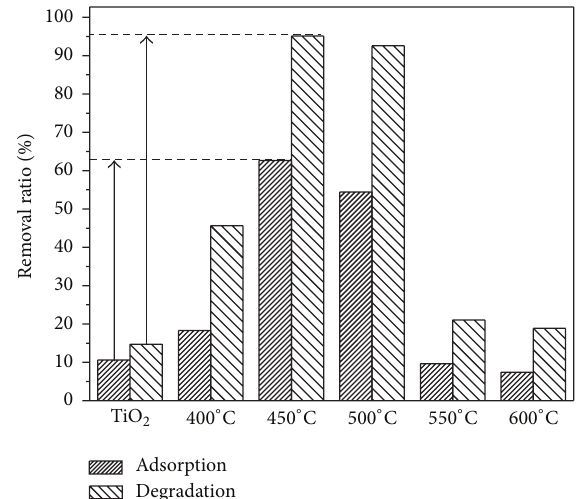
Figure 6: UV-Vis DRS of the pure TiO 2 and g-C 3 N 4 /TiO 2 samples obtained under different temperatures. Figure 7: Adsorption and photocatalytic activity of the pure TiO 2 andg-C 3 N 4 /TiO 2 samplesobtainedunderdifferenttemperaturesfor removal of